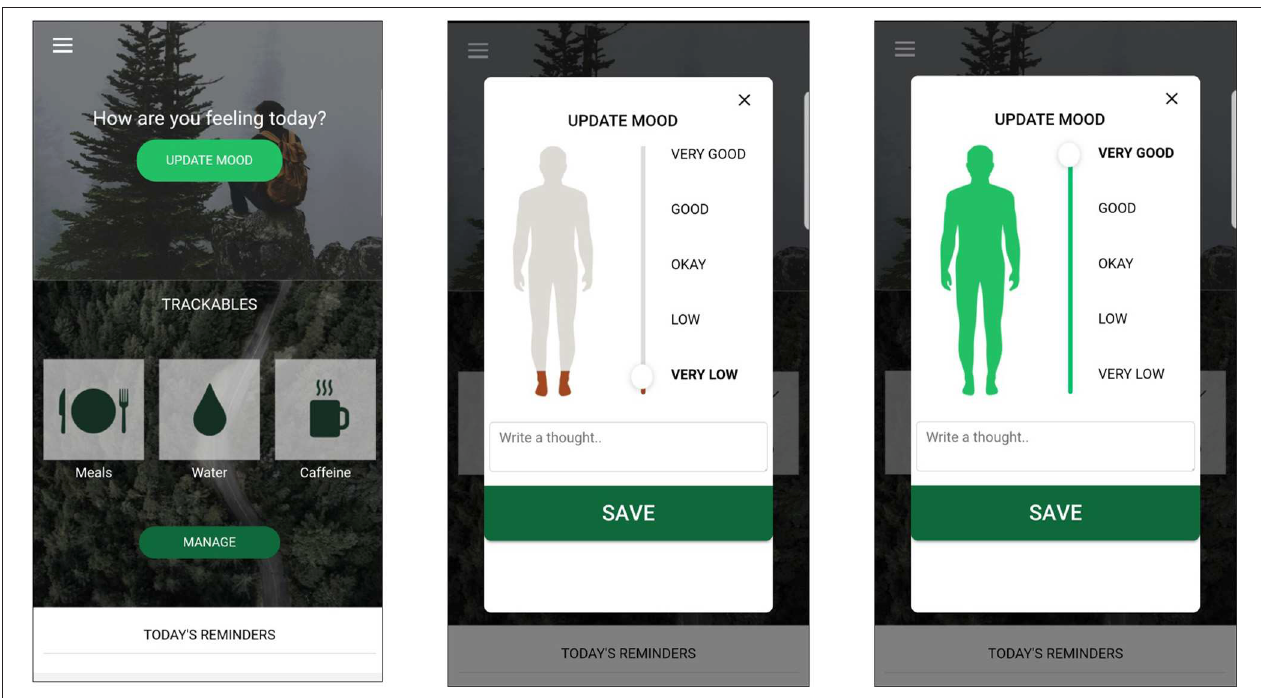
FIGURE 2 | BEACON Rx app update mood